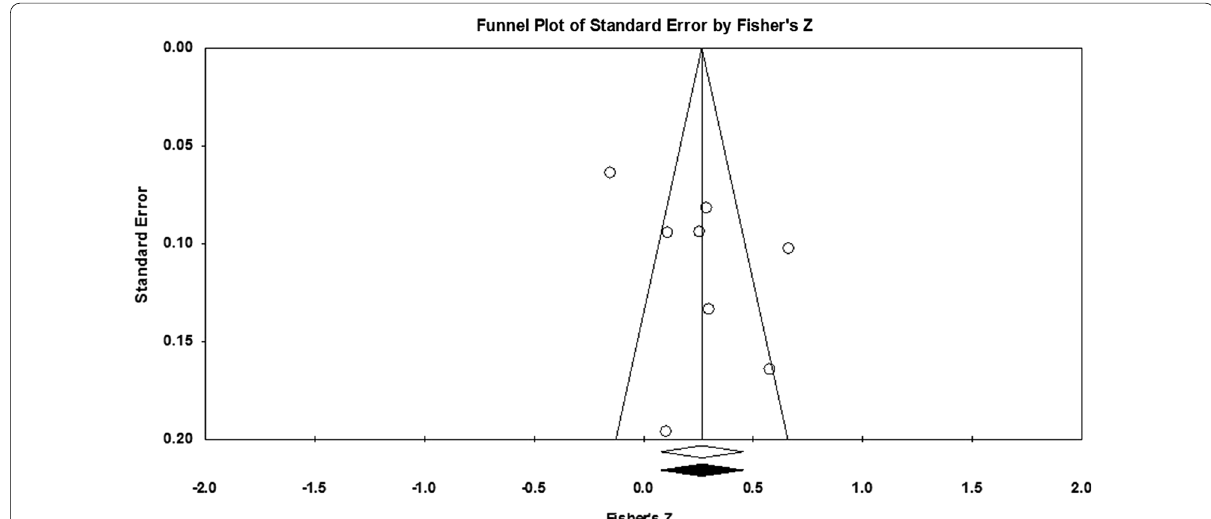
Fig. 4 Funnel plot: Publication Bias and the c- factor. Note. The funnel plot estimates the number of missing studies, assuming they retain the null (e.g., demonstrate zero correlation), required to reduce the Z-value below a .05 alpha (two-tailed) cutoff of 1.96. In this instance, the presence of empty dots (i.e., actual studies) and the absence of black-filled dots (i.e., imputed studies) suggest publication bias has not been detected using this test